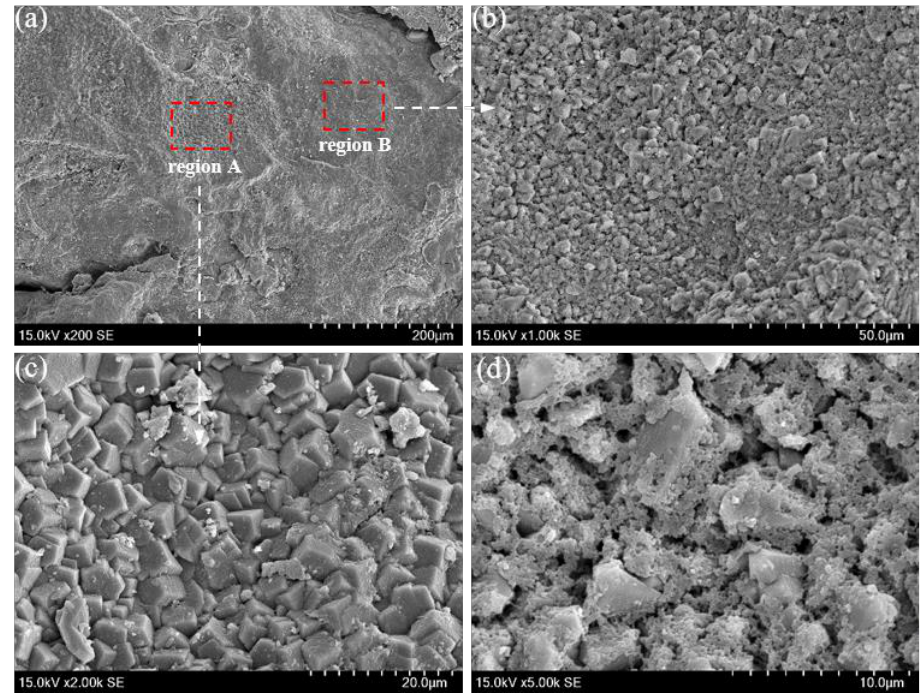
Figure 8. SEM images of surface morphology on outer wall of tubing. ( a ): 200 × SEM; ( b ): 1000 × SEM images of surface morphology on outer wall of tubing. ( a ): 200 × SEM; SEM; ( c ): 2000 × SEM; ( d ): 5000 × SEM. ( b ): 1000 × SEM; ( c ): 2000 × SEM; ( d ): 5000 ×